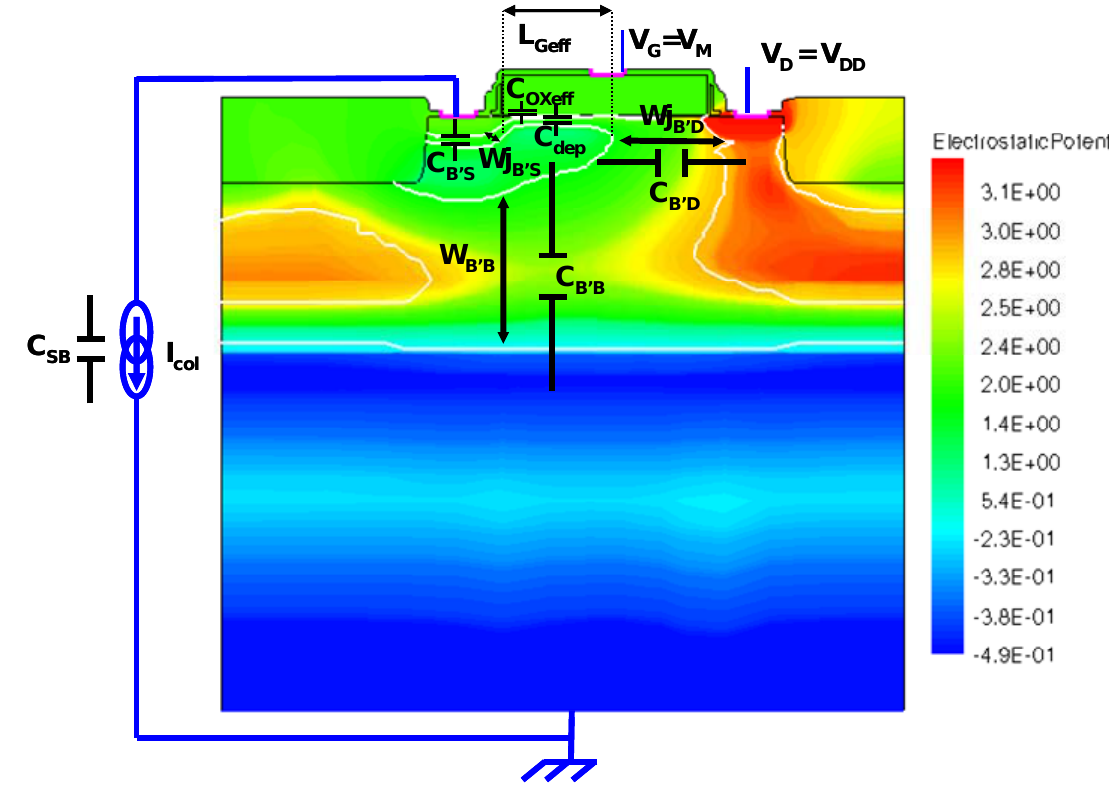
Figure 5. Simulated 1T pixel structure in readout phase with indication of parameters.